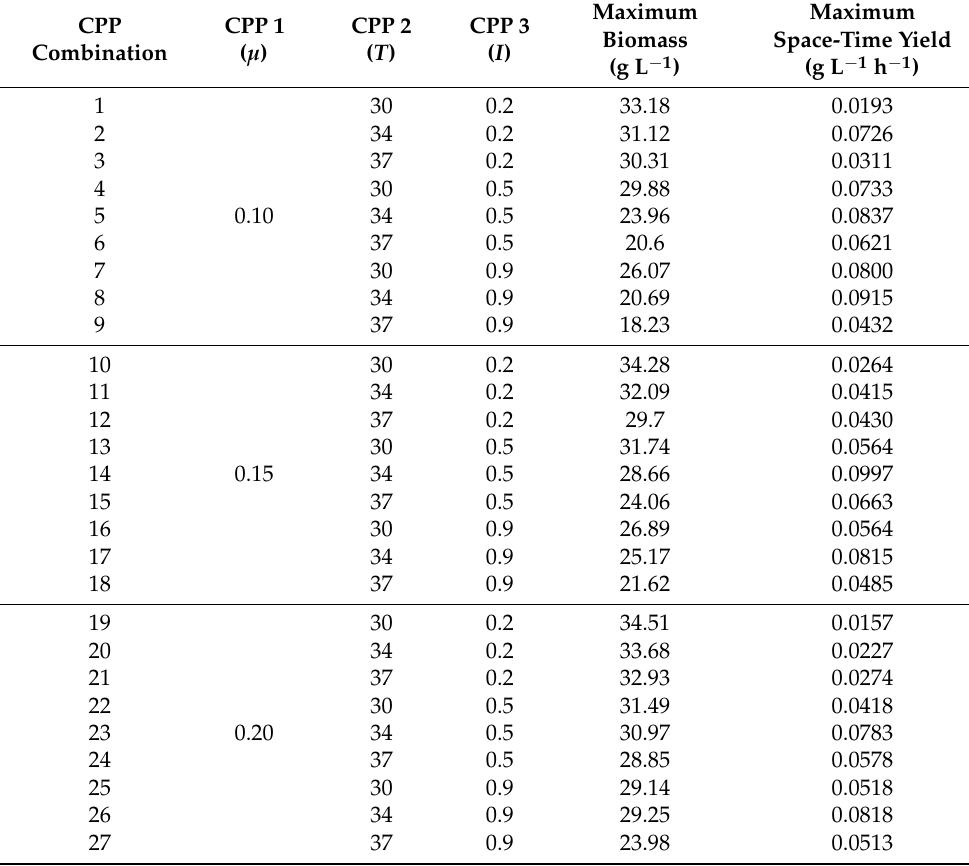
Table A1. CPP combinations of the static experiments for the model-based DoE